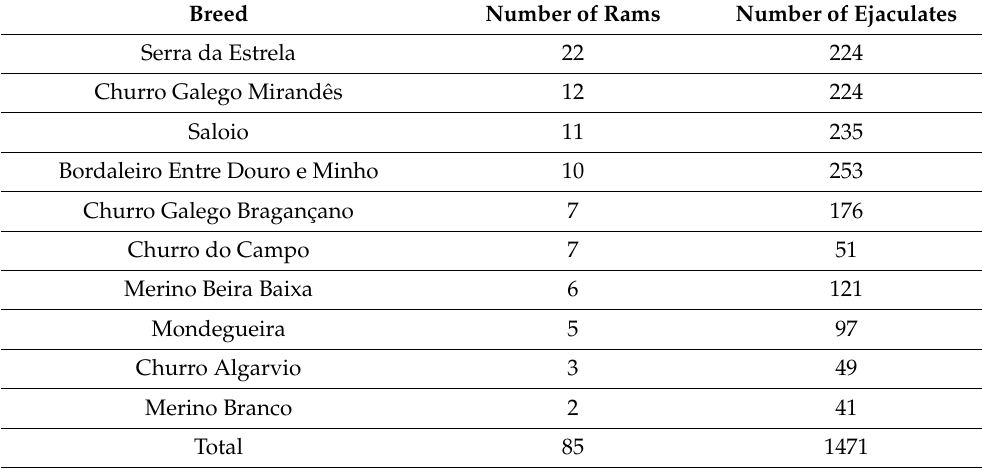
Table 1. Ram breeds, number of animals and ejaculates obtained from 2004 till 2020. Breed Number of